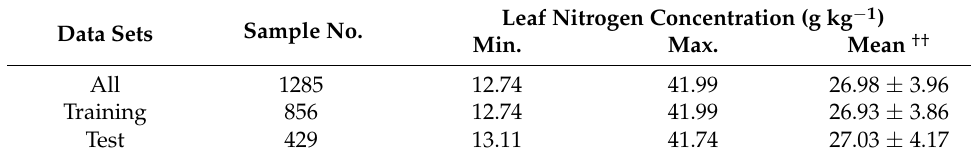
Table 3. Statistical values of N concentration of pear leaves used for training and test. Data Sets